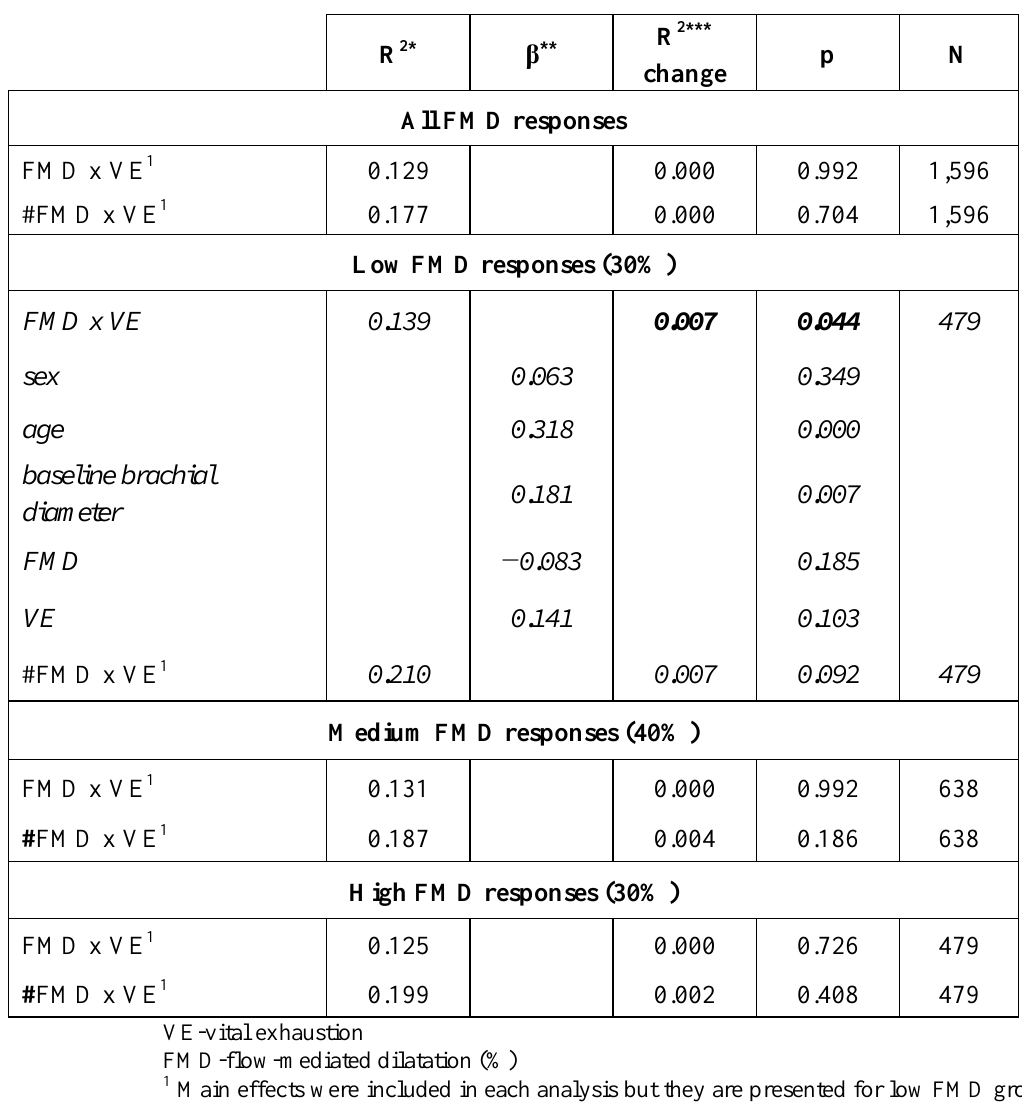
Table 4. Regression analysis of interaction between flow-mediated dilatation and vital exhaustion in predicting